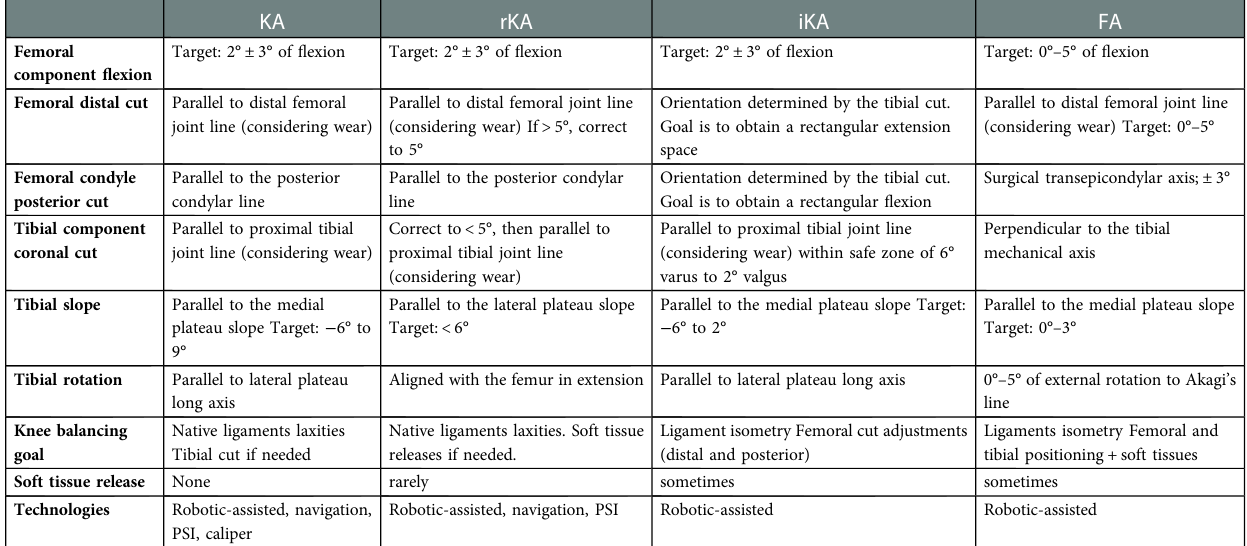
TABLE 1 Summary table of personalized TKA techniques.